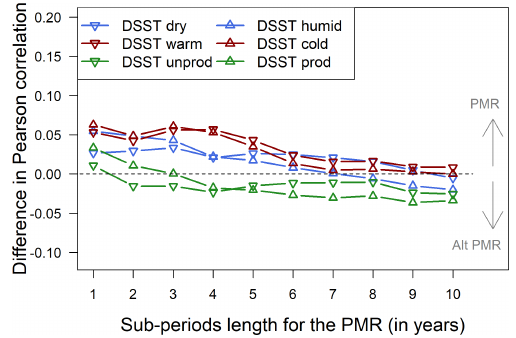
Figure B1. Differences between the correlations of PMR and alter- native PMR with DSST biases (performed on 6-year calibration and evaluation periods), depending on the DSST experiment and on the length of the sub-periods used for the computation of the PMR. Val- ues above zero indicate better agreement between PMR and DSST results compared to alternative PMR, and vice